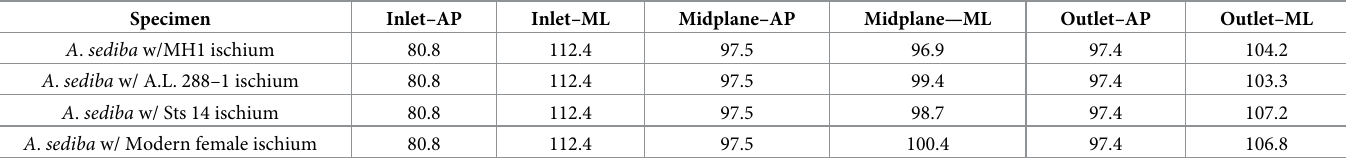
Table 3. Estimated obstetric plane measures for A . sediba